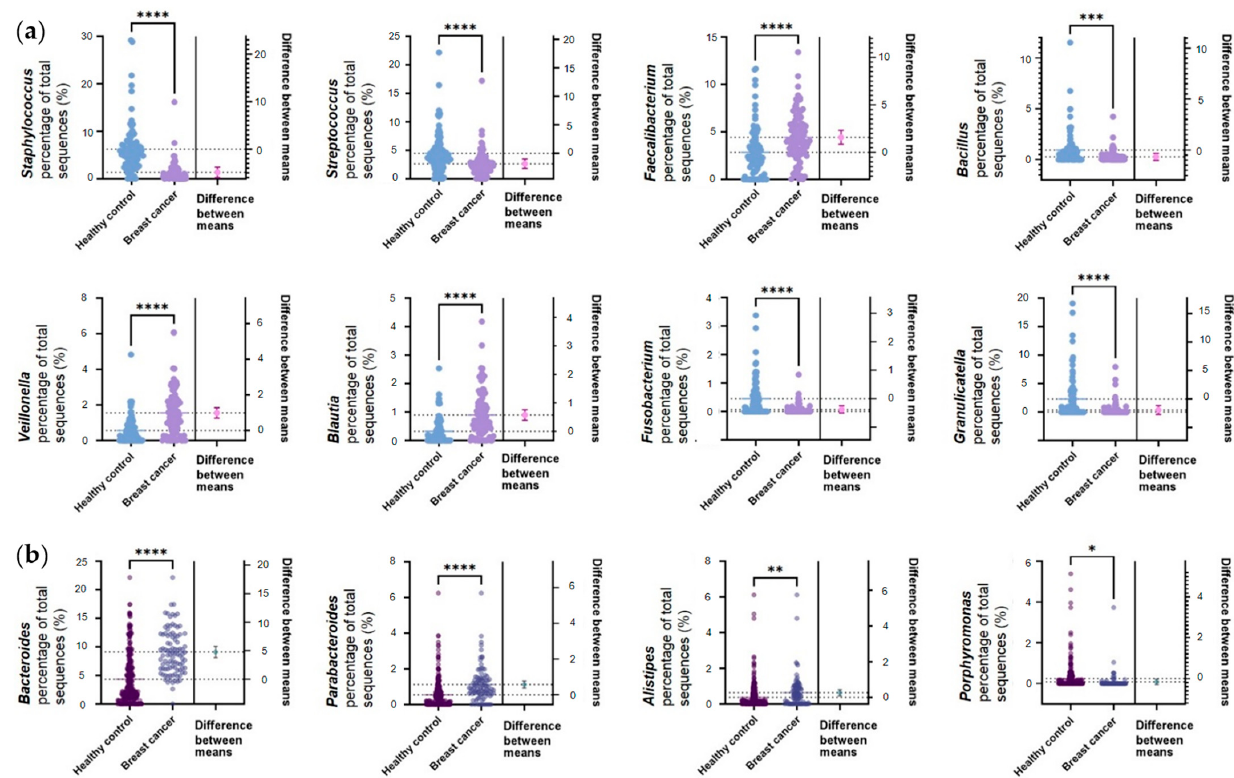
Figure 2. Microbiome differences of the Firmicutes and Bacteroidetes genus-level abundances between healthy controls and patients with breast cancer. ( a ) Statistically significant differentially abundant bacteria from genera of Firmicutes. ( b ) Statistically significant differentially abundant bacteria from genera belonging to Bacteroidetes. * p ≤ 0.05, ** p ≤ 0.01, *** p ≤ 0.001, **** p ≤ 0.0001.